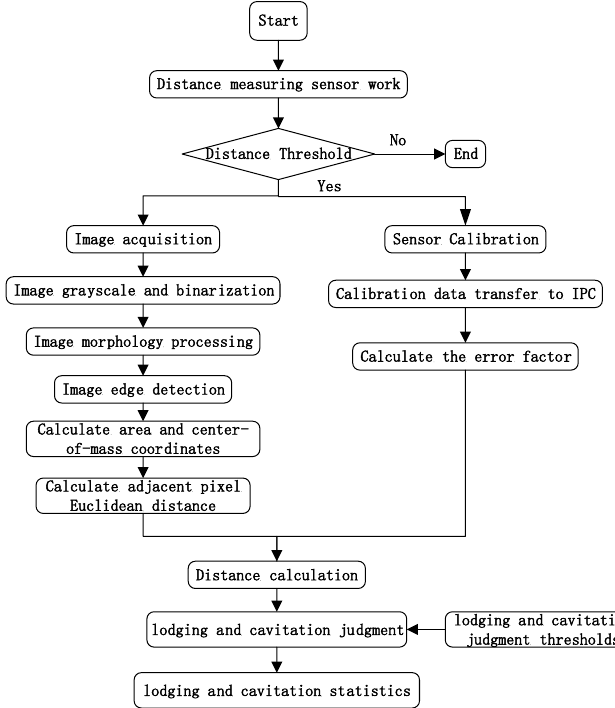
Figure 2. Diagram of the monitoring system process.